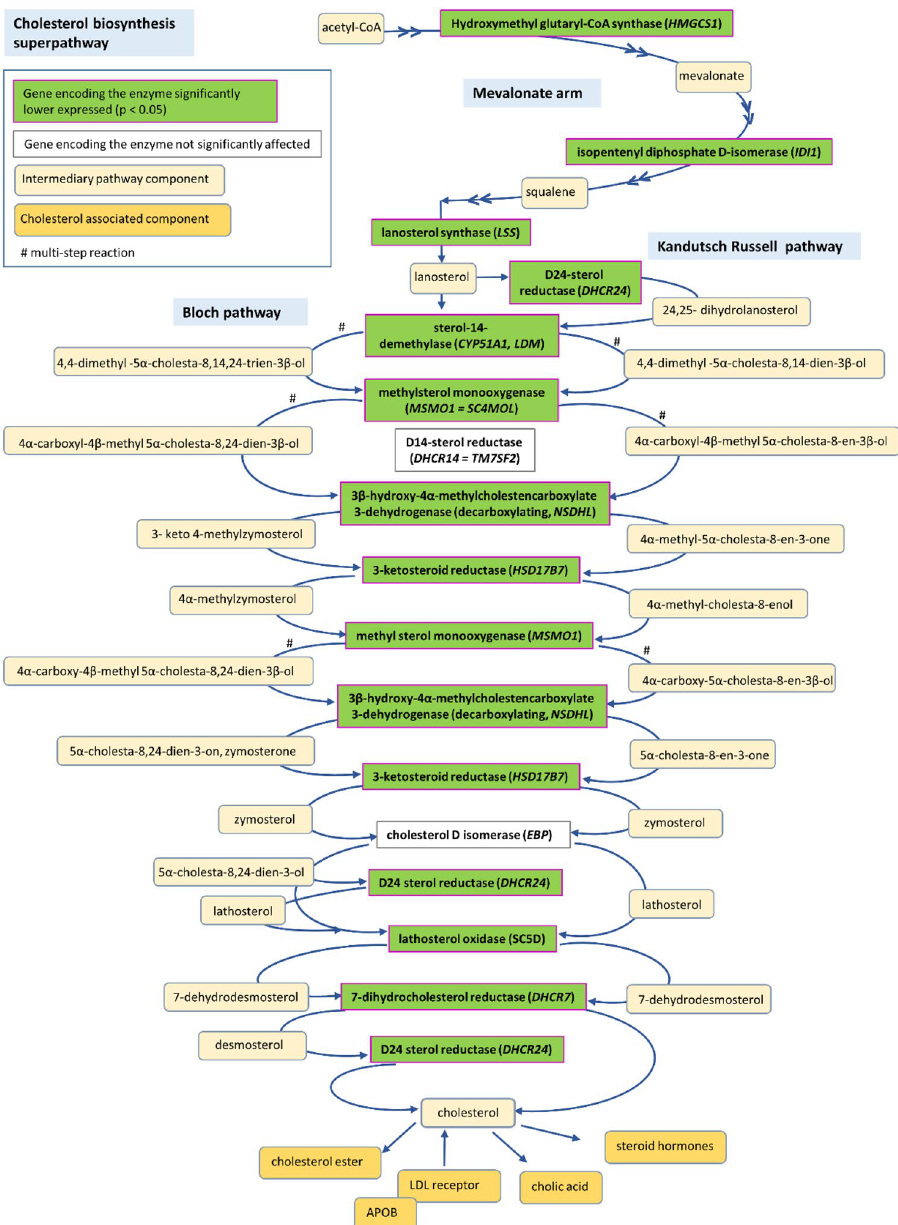
Figure 2. Ingenuity pathway Cholesterol Biosynthesis Superpathway significantly enriched of genes differentially expressed in the hepatic transcriptome between CDC and CDF